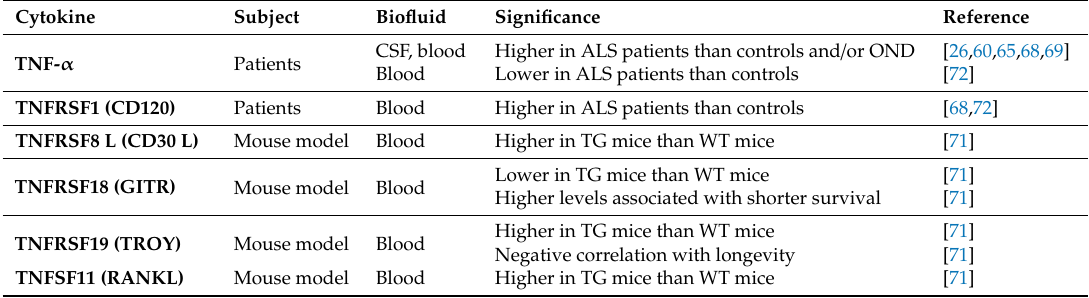
Table 2. Tumor necrosis factors (TNF) found dysregulated and proposed as biomarkers in biofluids from ALS animal models and